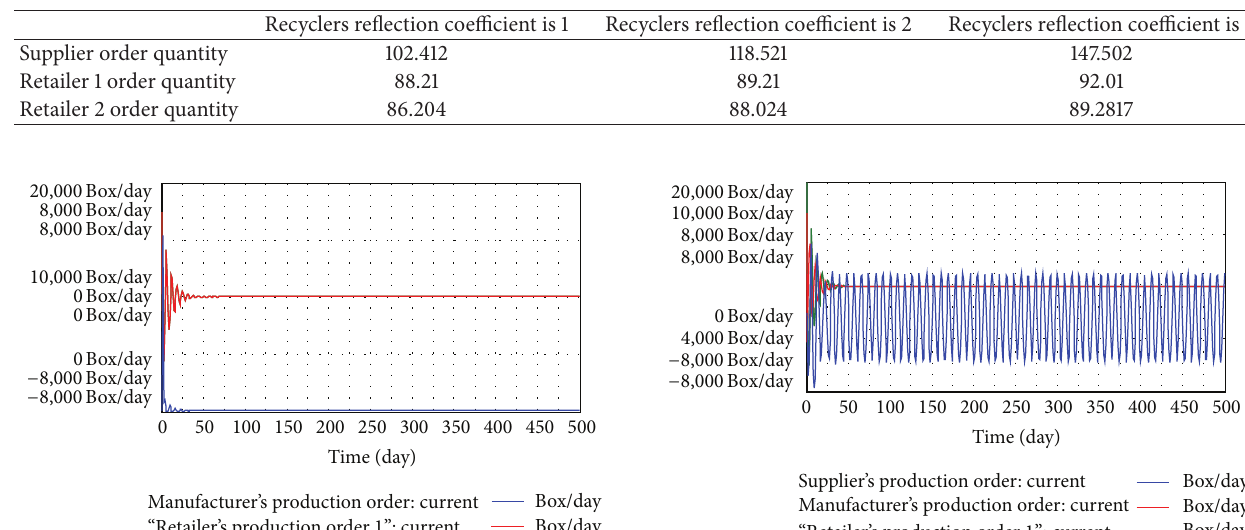
Table 4: The bullwhip effect when parts recycling delay times are different.